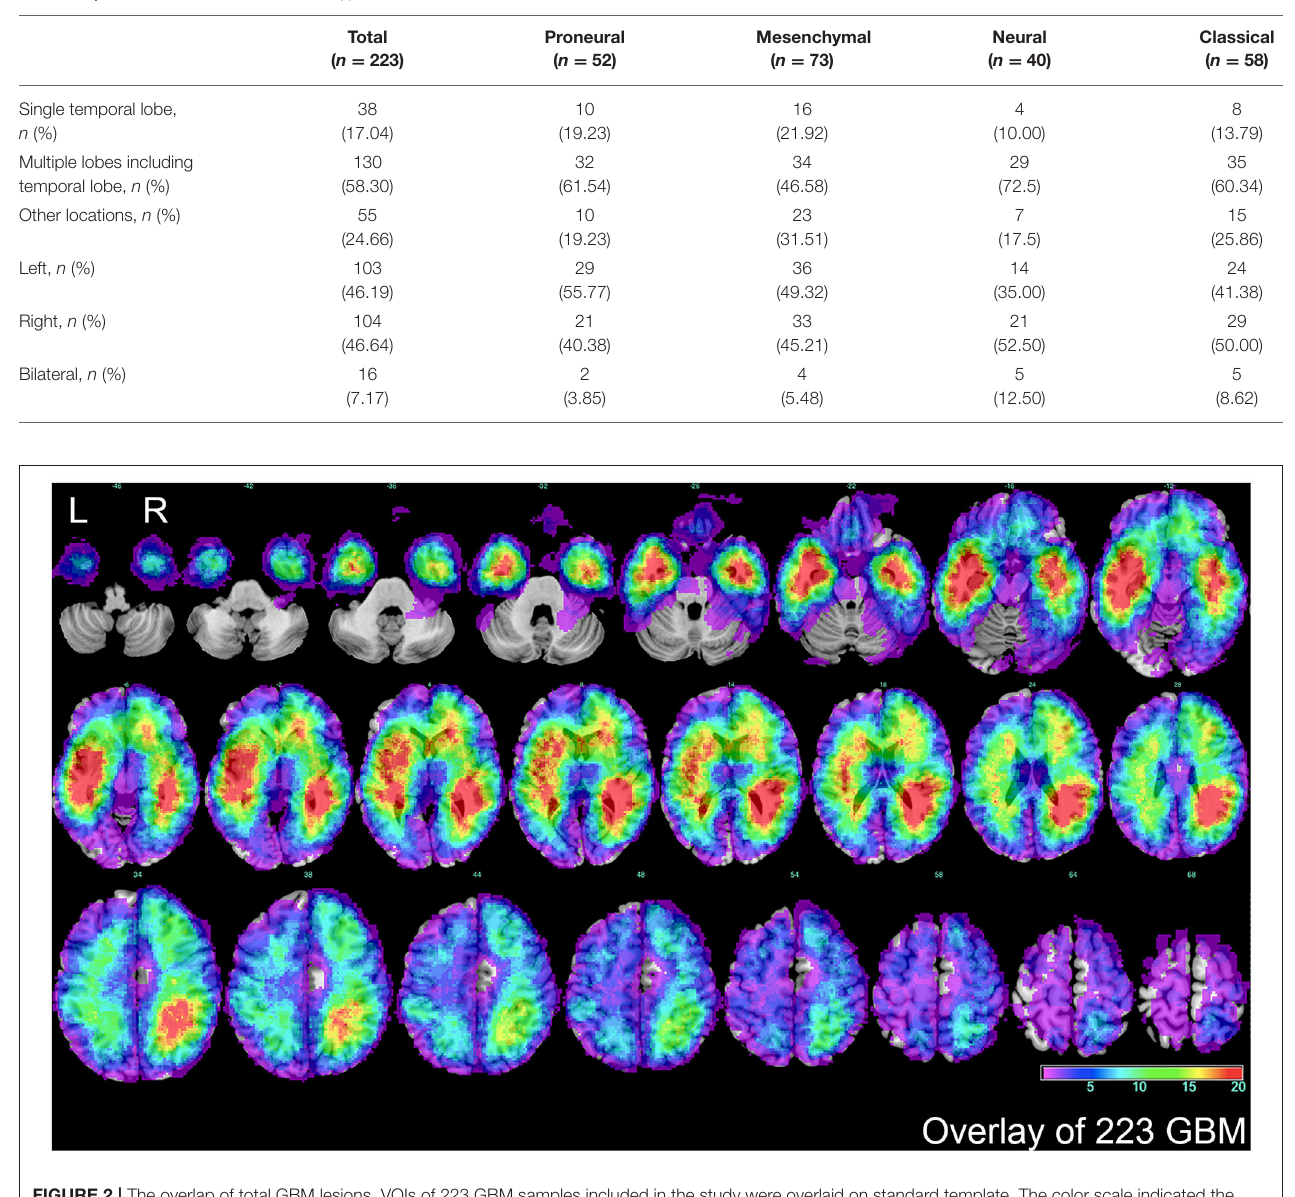
FIGURE 2 | The overlap of total GBM lesions. VOIs of 223 GBM samples included in the study were overlaid on standard template. The color scale indicated the amount of the VOIs overlap from violet (1 case) to red (more than 20 cases). The distribution showed that a majority of GBM located in periventricular or subventricular region. L represented left side, and R represented right